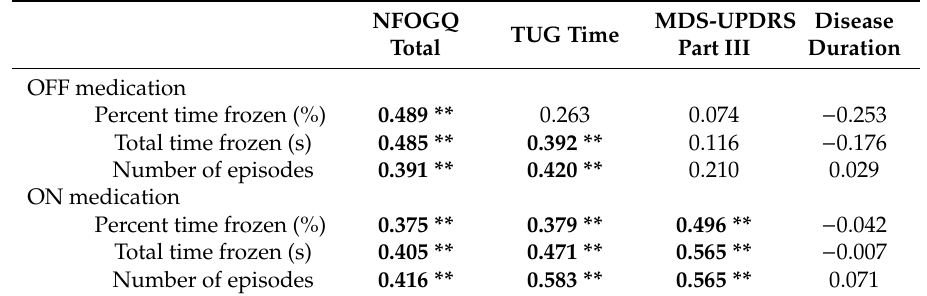
Table 5. Spearman correlations of percent time frozen, as detected by the algorithm and NFOGQ score, TUG time, and MDS-UPDRS part III score in OFF–ON medication